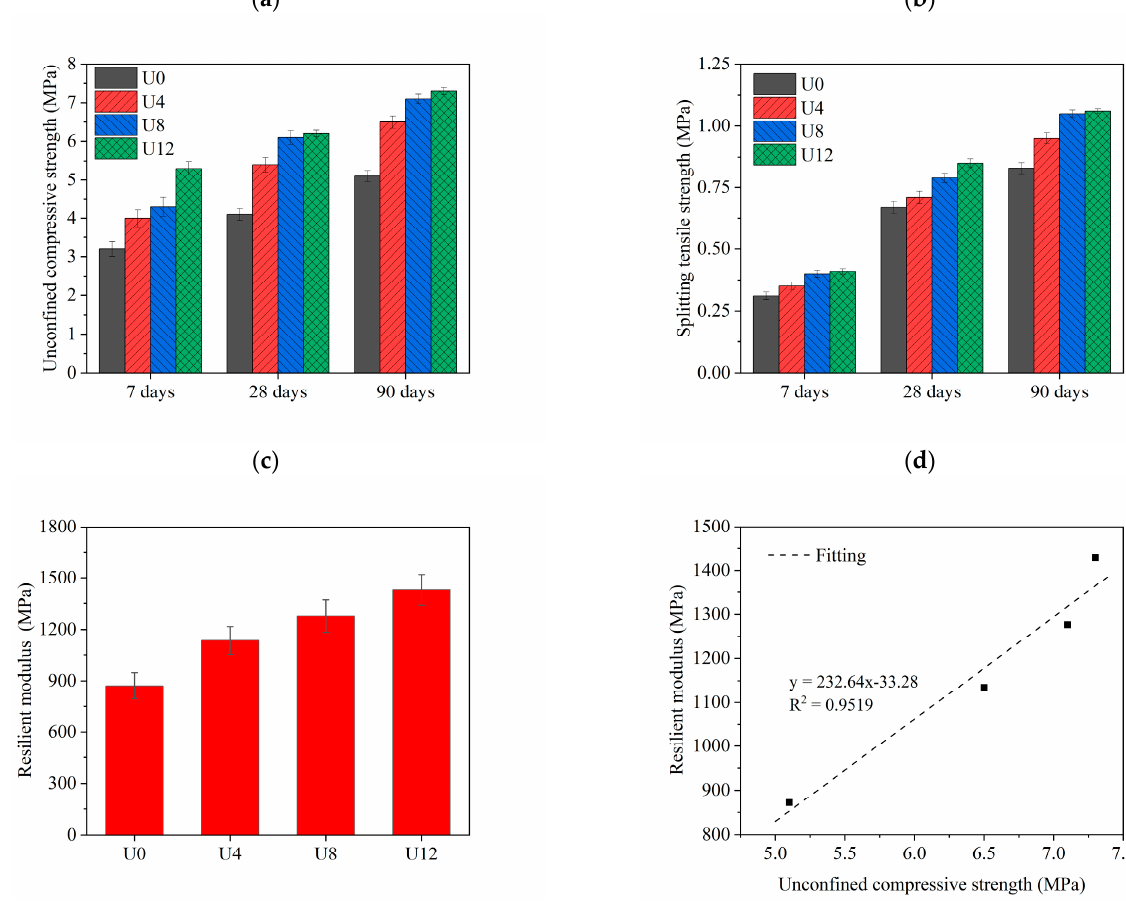
Figure 4. Mechanical properties ( a ) Unconfined compressive strength; ( b ) Splitting tensile strength; ( c ) Resilient modulus at 90 days; ( d ) Fitting of unconfined compressive strength vs. resilient modulus at 90 days.